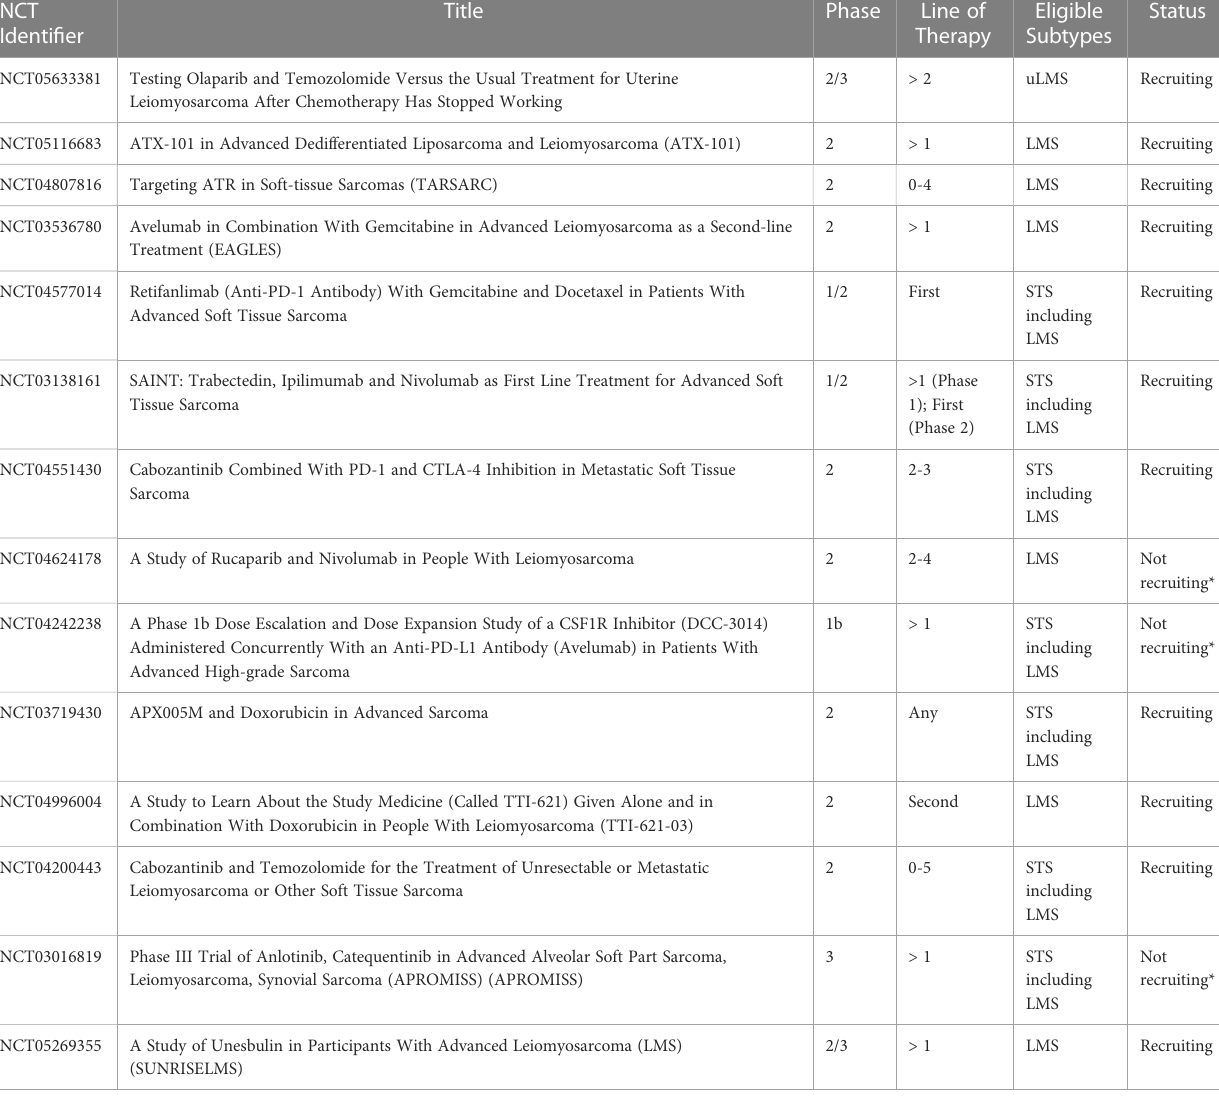
TABLE 2 Selected ongoing clinical trials in